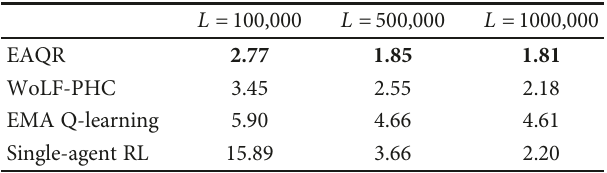
Table 3: Maximal steps for 4-agent/12-vertex box-pushing (evaluation episodes =50,000).